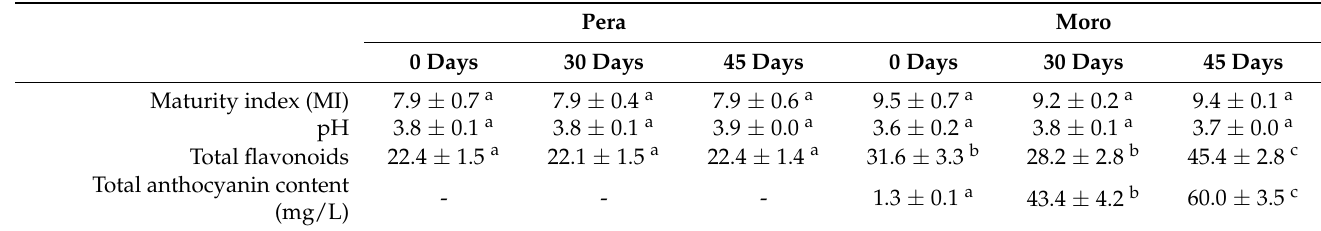
Table 1. Maturity index, pH, flavonoids and anthocyanin content of Pera and Moro pulp during storage for 0, 30 and 45 days. Statistical analyses were performed using ANOVA and different letters indicate statistically significant different values ( p ≤ 0.01) for a given time.